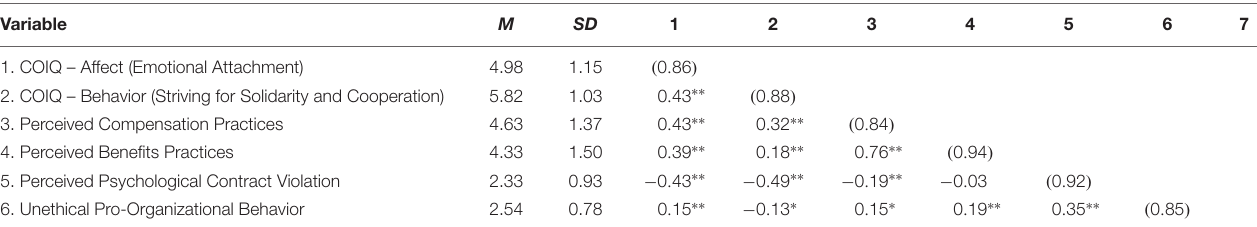
TABLE 6 | Descriptive statistics of and bivariate correlations between the COIQ dimensions and the antecedents and the outcome variables (Study 2). Variable M